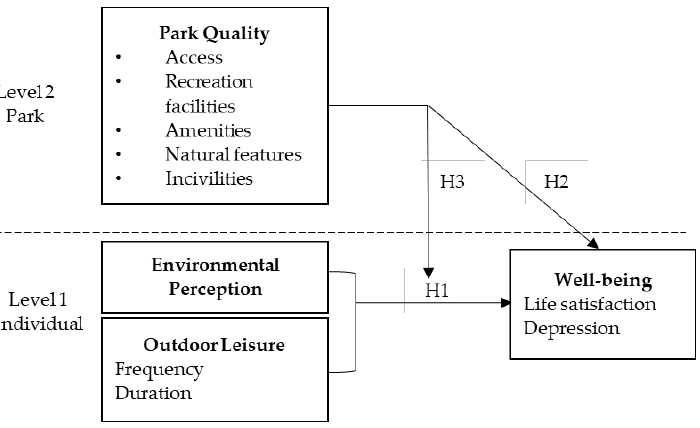
Figure 2. Theoretical framework and hypotheses.